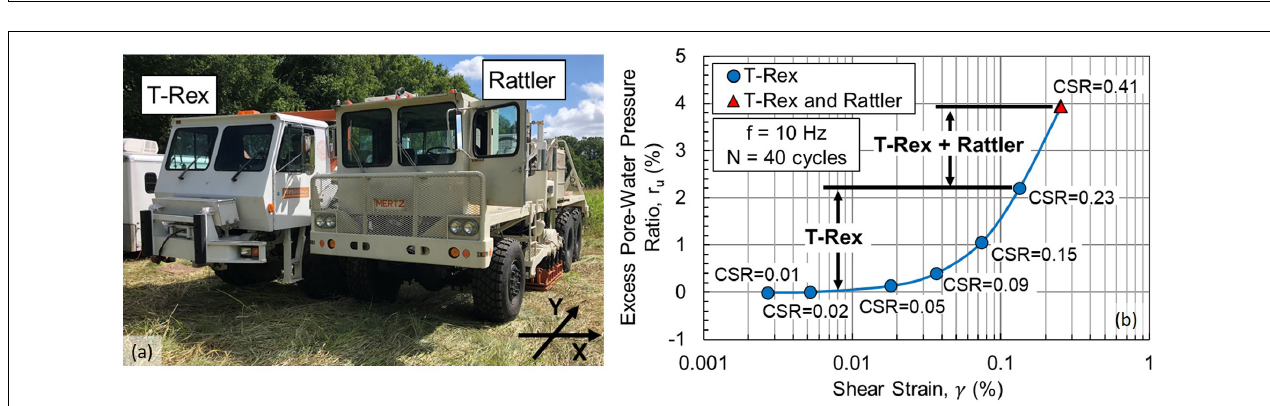
FIGURE 8 | Combined synchronized loading with T-Rex and Rattler in field shaking tests: (a) T-Rex and Rattler parked side by side and (b) Improved dynamic loading creates larger strains (after Zhang et al., 2019).